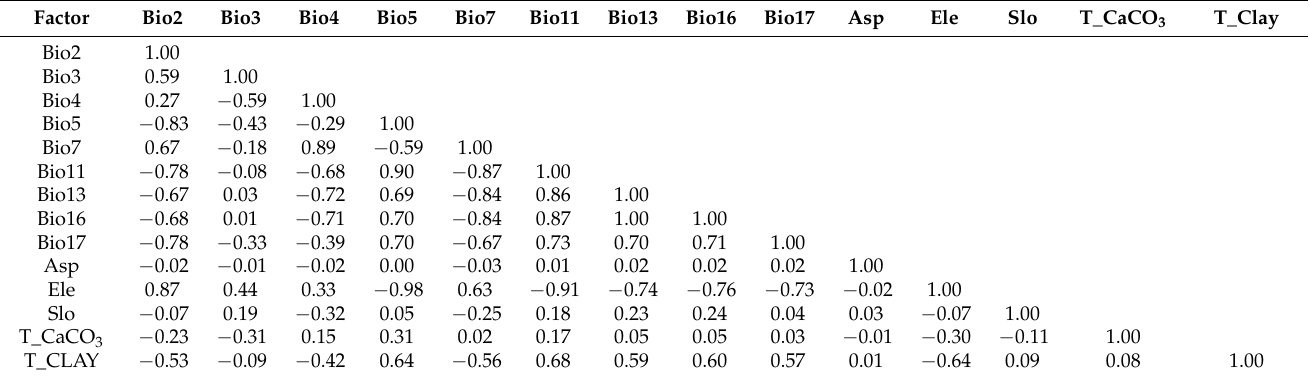
Table A4. Multi-collinearity test by utilizing correlations among climate variables for R. singorand .